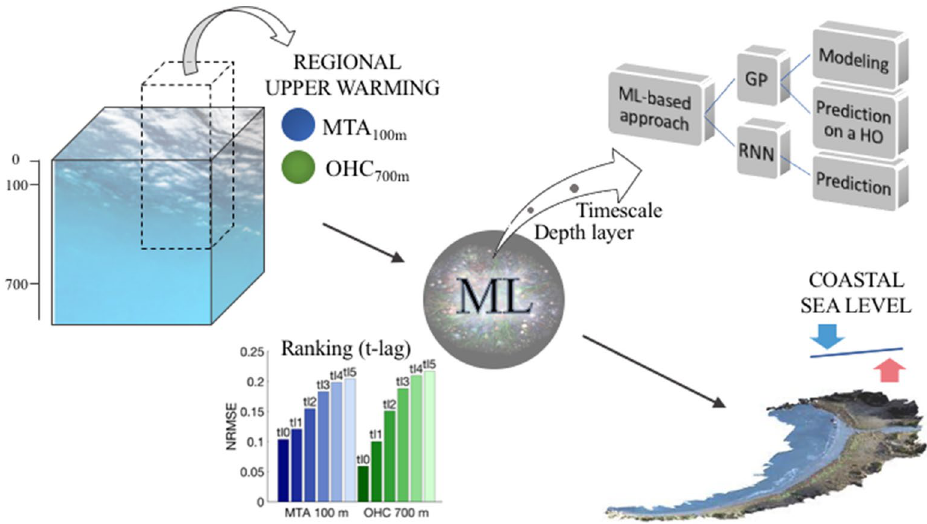
Figure 1. Illustration of our ML approach. The proposed approach combines physical variables (that reflect upper-ocean temperature changes) in open ocean regions and ML techniques (i.e., the nonlinear GP and RNN methods) to assess coastal sea level variability in these regions across a range of timescales. This framework includes a relevance criterion to rank the physical variables according to their performance modeling such changes, while also considering different time lags (Figs. S1-S4).